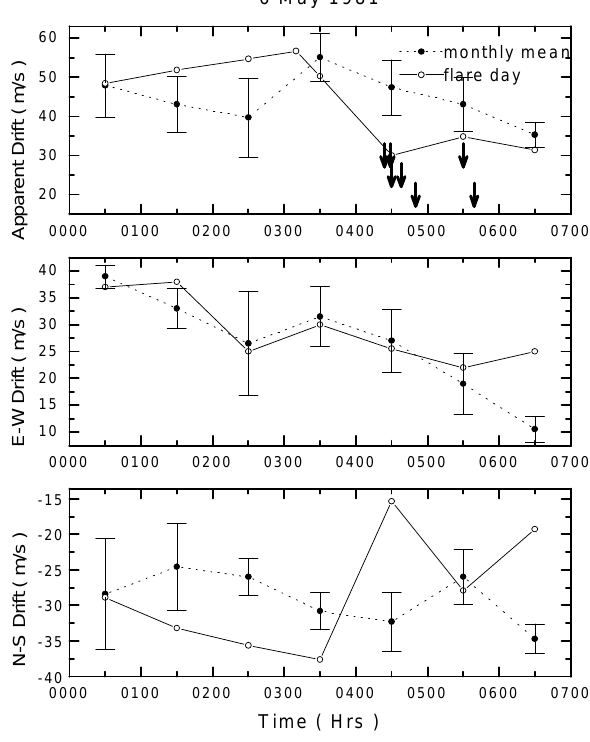
Fig. 2. Variation of Apparent Drift Speed, its E–W and N–S com- ponents on 6 May 1981, along with their respective monthly mean variation. Solar flares occurred at 04:24, 04:29 and 05:30 (2B), 04:30, 04:38 and 05:30 (1N), and 04:50 and 05:39 (1F). The rest of the details are the same as in Fig.